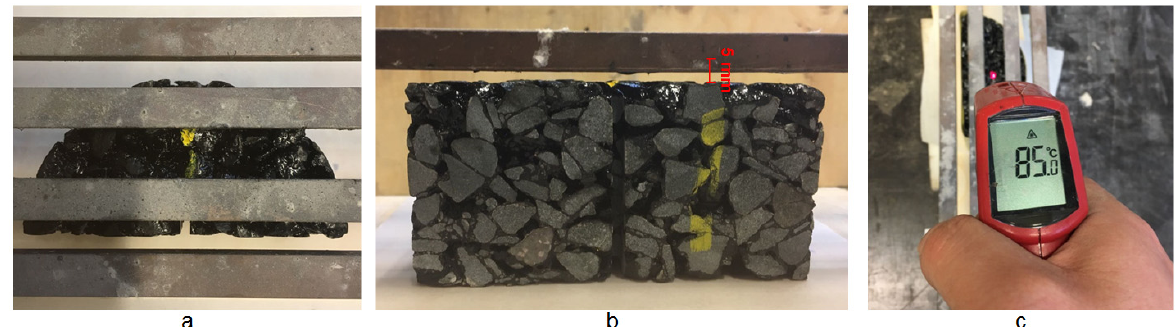
Figure 2. Tested SCB specimen under the induction coil: (a) top view; (b) front view and (c) surface